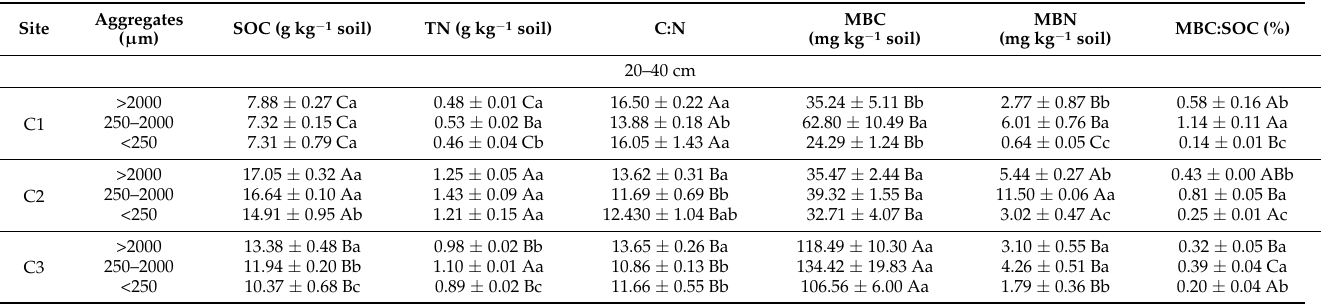
RDA was used to explain SOC and TN using soil enzyme activities (AMY, INV, BG, (Figure 4a), the first two axes accounted for 96.31% of the variance for axis 1 and 2 ex- plained a variance of 96.23% and 0.08%, respectively. Significantly positive correlation between SOC and NAG, and TN and GLU were detected in macro-aggregates. In meso- aggregates (Figure 4b), axis 1 and 2 explained 94.99% and 0.06% of the total variance. Sig- nificantly positive relationships were observed between SOC and NAG, TN and URE in meso-aggregates. In micro-aggregates (Figure 4c), the first two axes explained 95.7% and 0.06% of the variance. SOC and NAG, TN, and URE showed significantly positive rela- tionships in micro-aggregates.